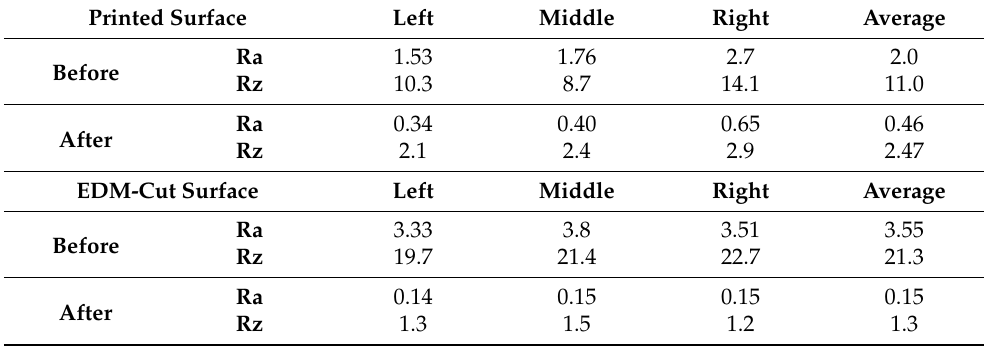
Table 6. Surface roughness measurement results (in µ m) of the fully heat-treated samples before the MAF process (H + A) and after the MAF process (H + A + MAF). Printed Surface Left Middle